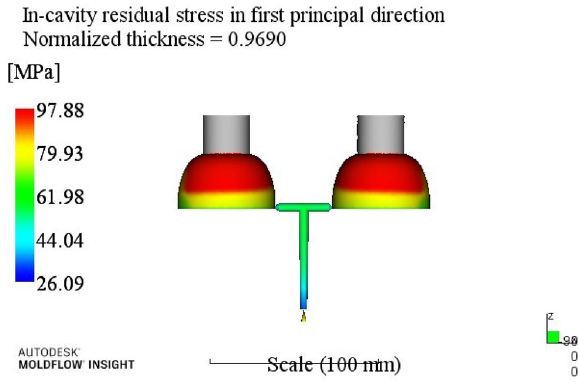
Figure 10. The simulation results of the first direction residual stress.